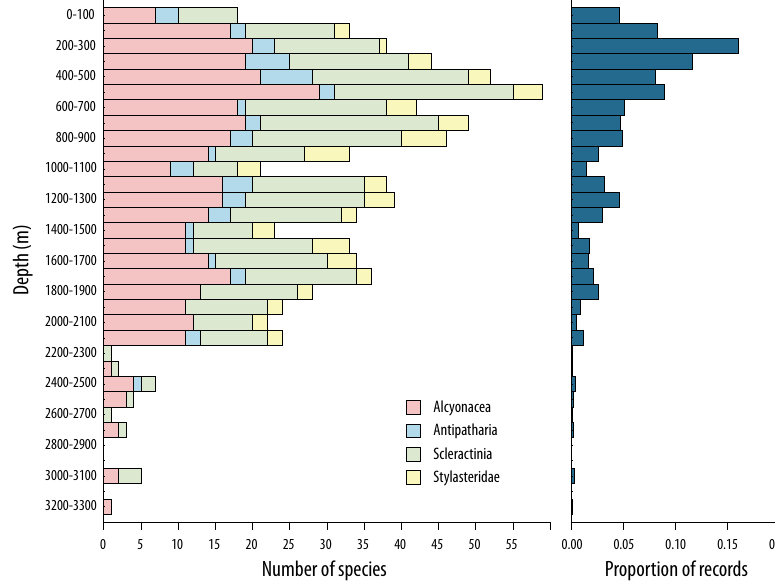
Fig. 6 . Summary of depth ranges for Alcyonacea, Antipatharia, Scleractinia and Stylasteridae.